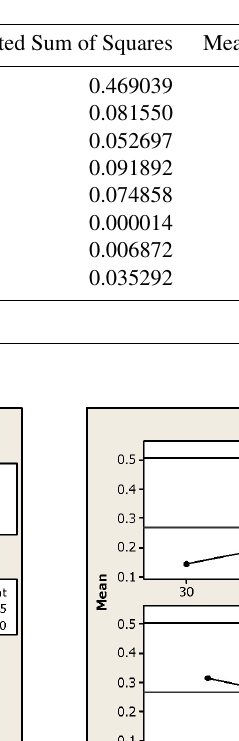
Table 7. Analysis of Variance for Wire Wear